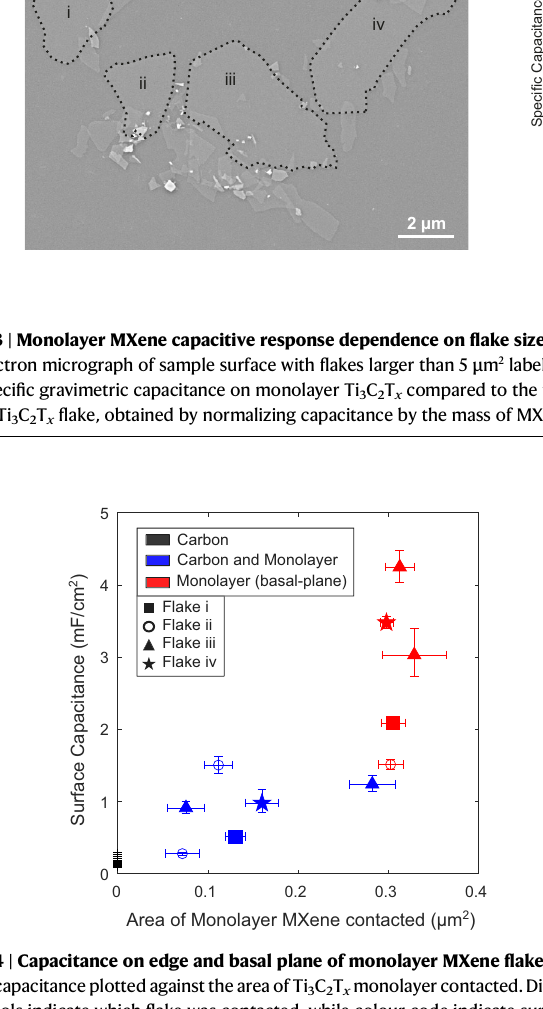
Fig. 4 | Capacitance on edge and basal plane of monolayer MXene fl akes. Sur- facecapacitanceplottedagainsttheareaofTi 3 C 2 T x monolayercontacted.Different symbols indicate which fl ake was contacted, while colour code indicate surface type. Data shows the mean and error bars represent the standard deviation.